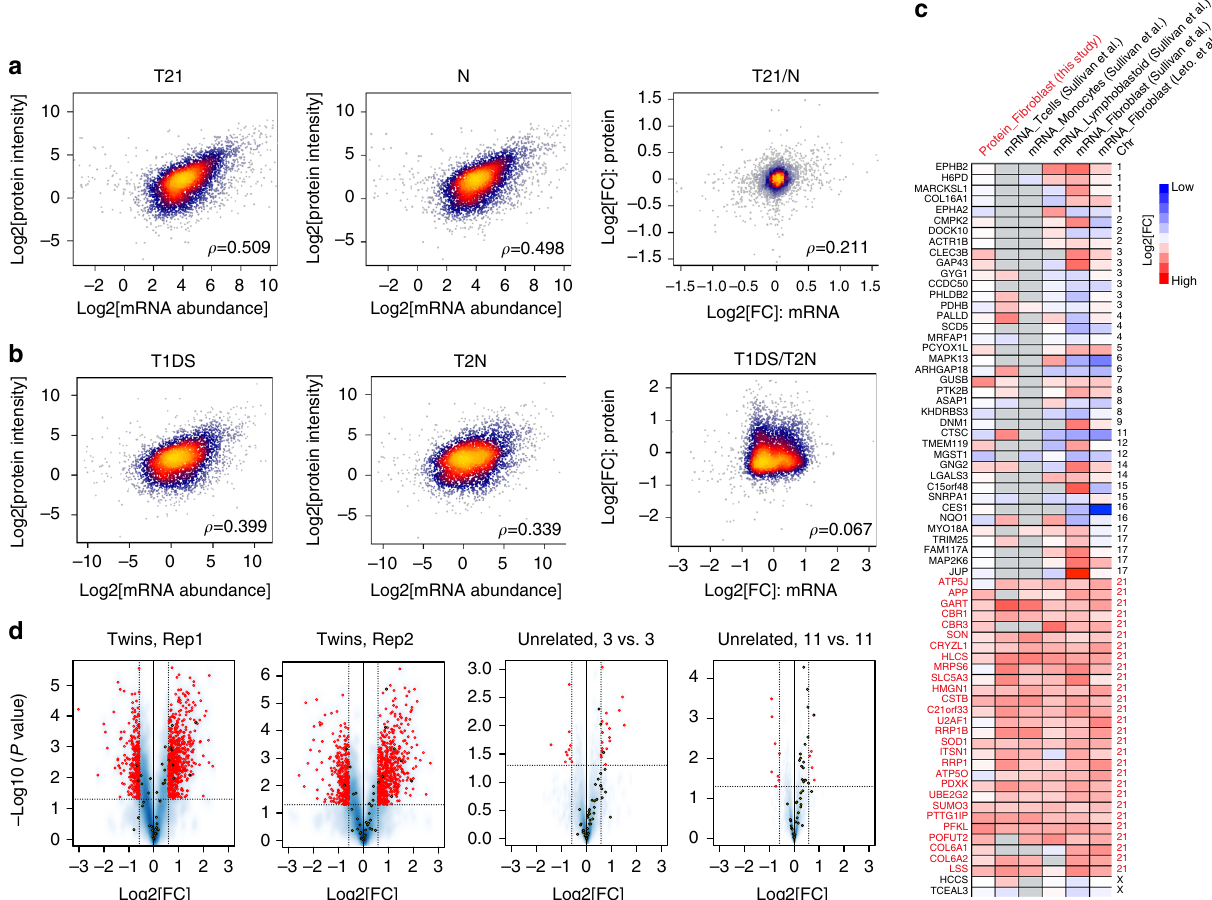
Fig. 2 Global and signi fi cant post-transcriptional regulations revealed by proteomic data. a Correlation analysis between mRNA abundance and total protein levels upon T21 revealed a moderate correlation across levels, and weak association regarding cross-layer effects of T21, re fl ected by matching unrelated samples. b Same analysis to a but in twin samples. c T21 transcript signatures discovered in fi broblast cells of Sullivan et al. 5 are conserved between cell types and impact protein levels. d Volcano plots were generated for twin samples (three aliquots of T1DS vs. three aliquots of T2N), three pairs of T21, and N samples (unrelated) and the whole unrelated sample set (11 T21 vs. 11 N). Rep1 and Rep2 mean two independent twin cell cultures. Red circles denote signi fi cant proteins of > 1.5-fold change (FC) at P < 0.05 (Student ’ s t test). The highlighted yellow circles denote Chr21 of our method covers over fi ve orders of magnitude in protein copy number per cell, ranging from hundreds to tens of millions copies (Methods; Supplementary Data 1).